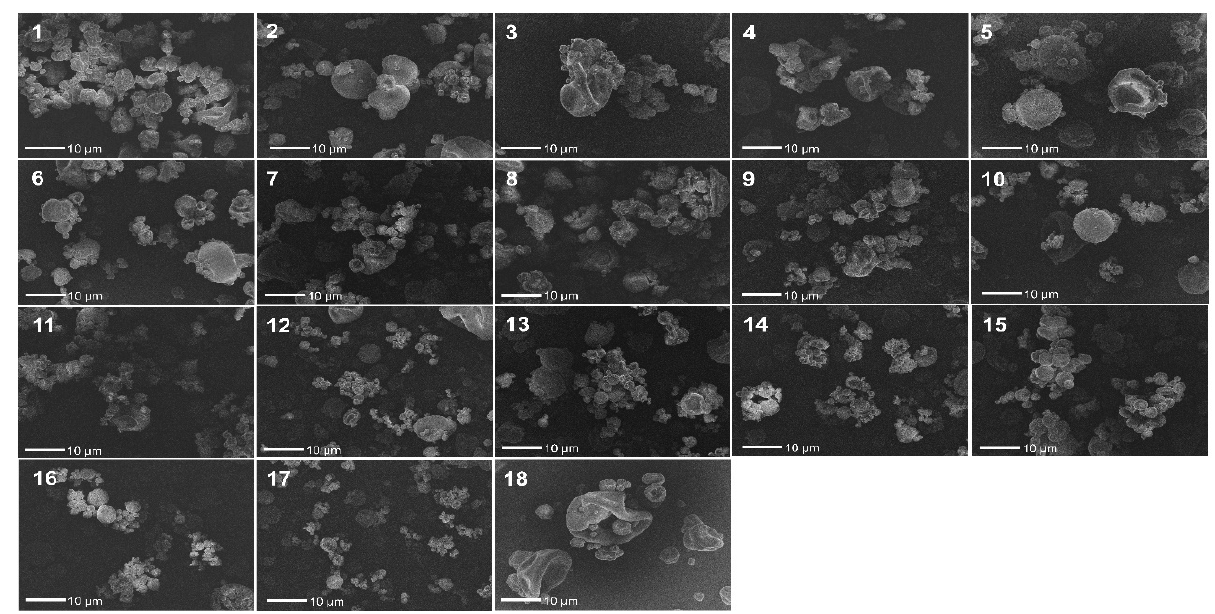
Figure 4. FEG-SEM images of RS/P samples prepared by spray drying employing different values for inlet air temperature, aspirator efficiency and feed flow rate, according to the factorial design outlined in Table 2. The images were obtained with 2000 × magnification.